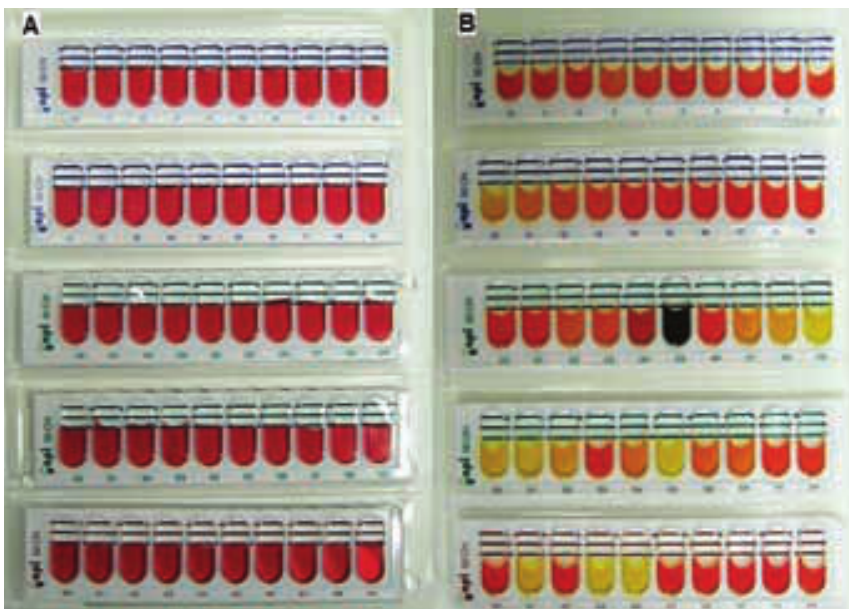
Figure 3. Carbohydrates utilized by B02489 (HU) isolates in different times (A: 0 h; B: 144 h) (0: control; 1-49 different carbohydrates; colour changes indicate the